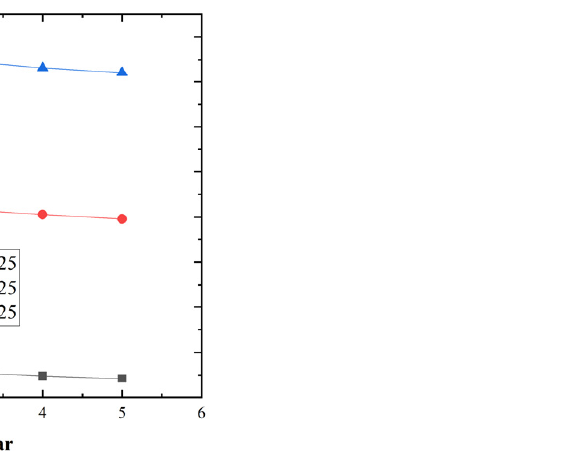
Figure 14. Heat extraction of the DBHE system under different thermal conductivities of formation.